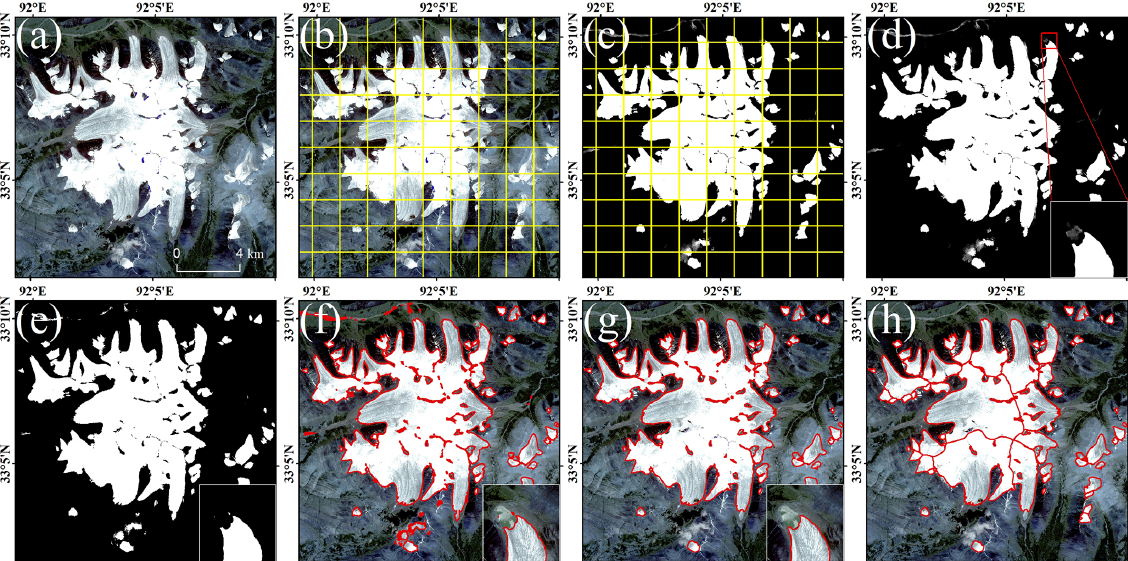
Figure 9. The procedure of glacier extraction. Firstly, the preprocessed image obtained on 19 August 2020. Panel (a) was clipped into 1024 × 1024 overlapping patches (b) , and then inputted into the model to obtain the predicted result (c) . Secondly, the results were merged, and pixel values greater than 0.5 were classified as glaciers to obtain the final binary map ( d and e ). Thirdly, the binary map from above can be converted to a vector (f) and smoothed (g) . Finally, the glacier was segmented using ASTER GDEM (global digital elevation model) to obtain individual glacier vector boundaries (h)